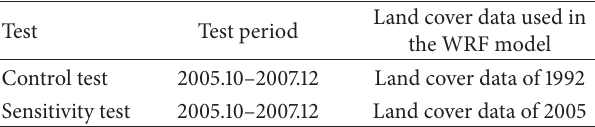
Table 1: Physical parameterization schemes. Table 2: Schemes of the simulation